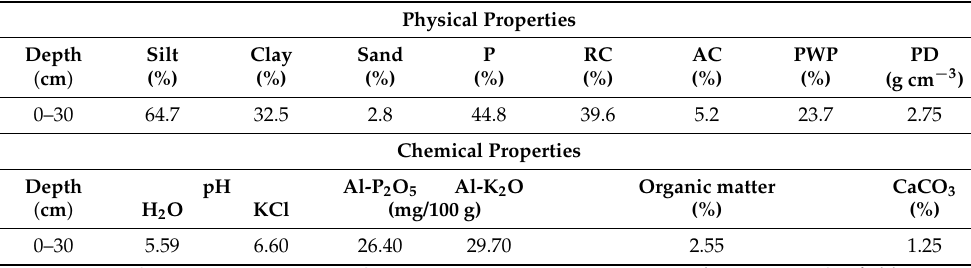
Table 1. Physical and chemical properties of the soil at the study